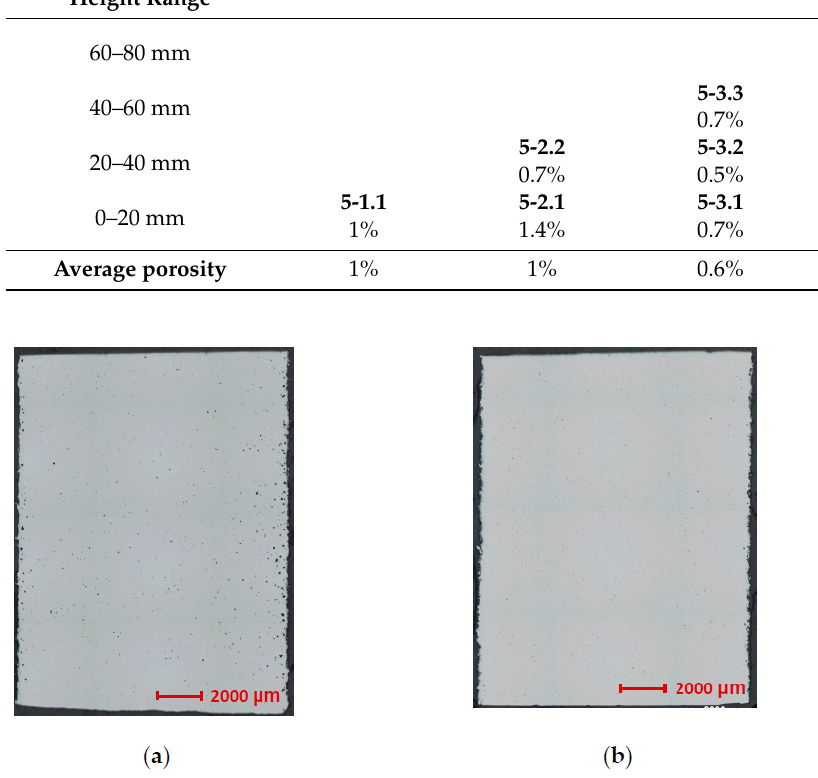
Figure 9. Test of bulk samples II, plane XZ, ( a ) 5-4.1; ( b ) 5-4.4.